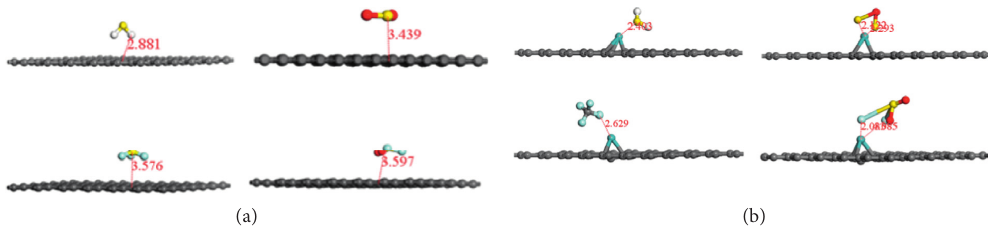
Figure 5: The most stable model of SF 6 decomposition gas adsorption: (a) grapheme and (b) Mo-doped